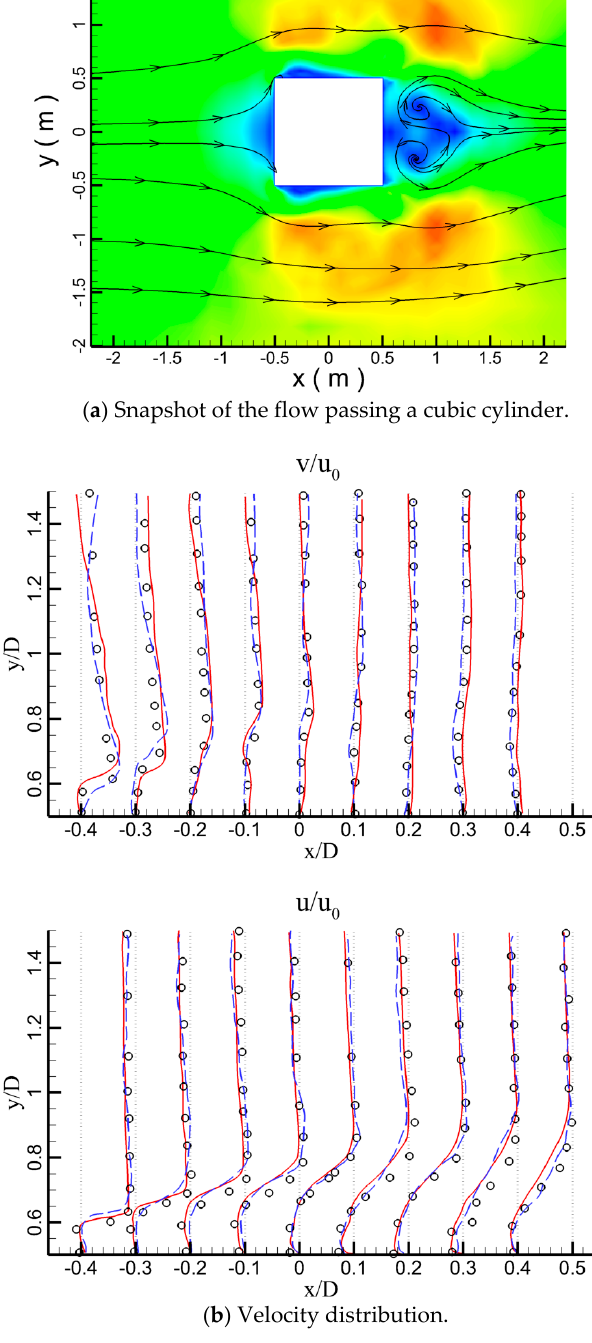
Figure 5. Flow passes a cubic cylinder at bottom of channel. ( a ) Computed flow field near the square cylinder. ( b ) Comparison of the velocity distribution. Circle-Measurement [30], dash-dot line, DNS modeling, solid line, SIFOM–FVCOM.